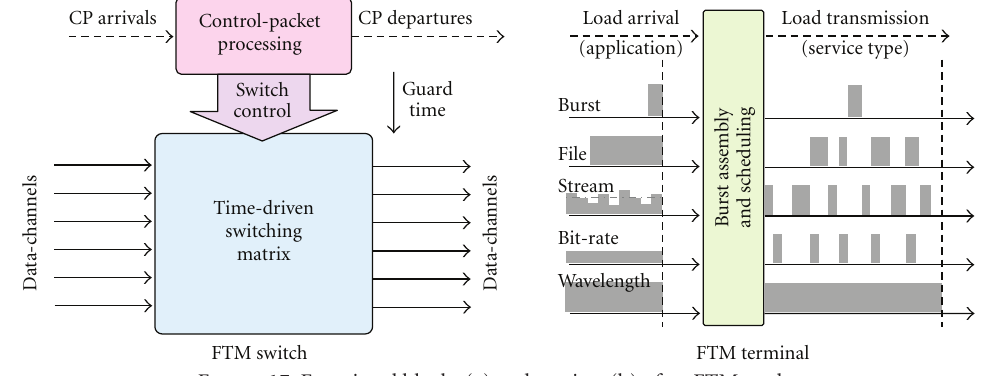
Figure 17: Functional blocks (a) and services (b) of an